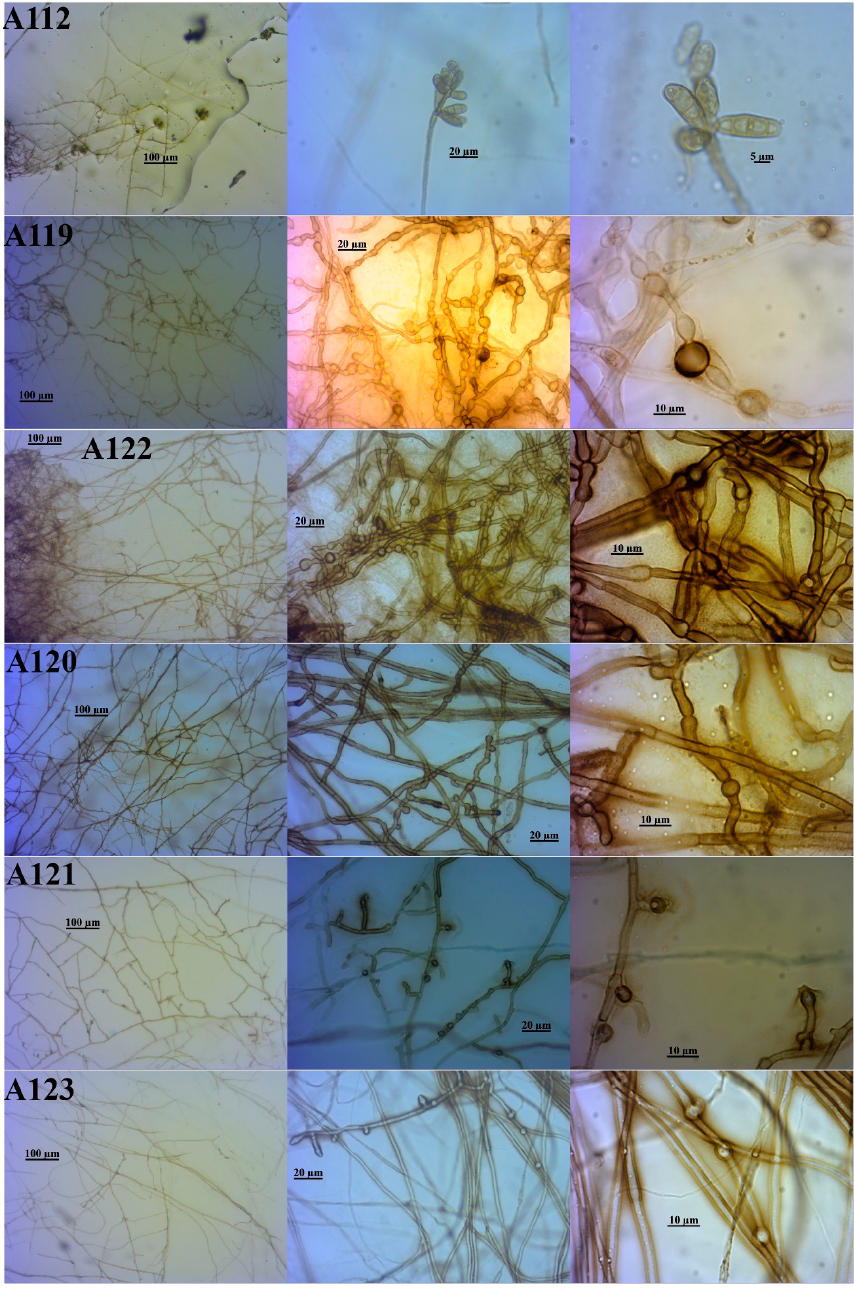
Figure 4. Micromorphology of hyphae and other fungal structures of DSE fungi (A112, A119–A123) grown in malt extract agar after isolation from sugarcane roots sampled in the Quatá region, São Paulo, Brazil.